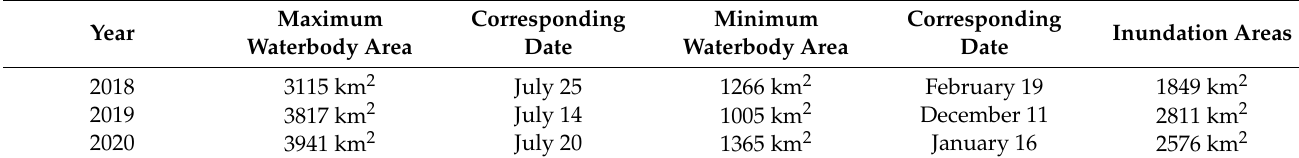
Table 2. Maximum and minimum water body and inundation areas and dates from 2018 to 2020 at Poyang Lake.